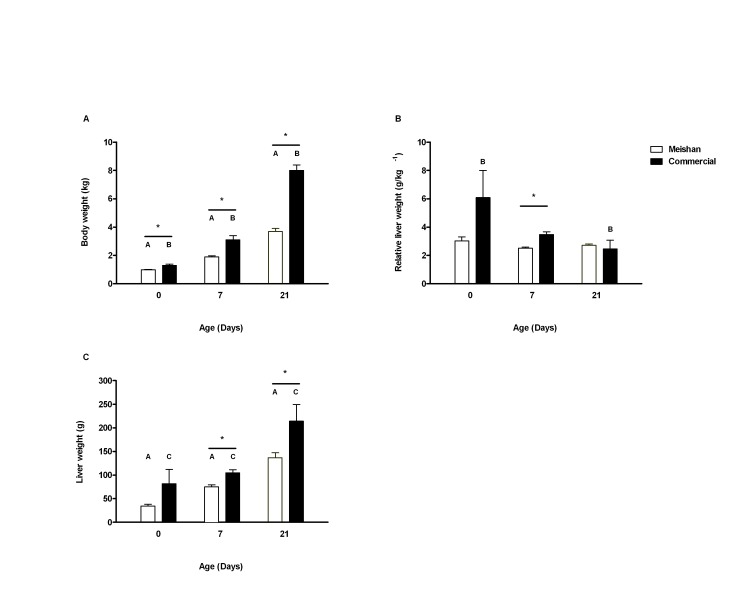
Body and liver weight with age and breed.Influence of breed on early growth in Meishan (open bars) and commercial (closed bars) piglets during the first 21 days postnatal life. (A) Changes in body weight, (B) Changes in liver weight and (C) Relative liver weight. A; p<0.05: statistical difference between the Meishan breed age groups, B; p<0.05: Statistical difference between the commercial age groups, C; p<0.05: Statistical difference between the 0 and 7 day old in comparison to 21 days old commercial breed group and *; p<0.05: Statistical difference between the same postnatal age groups. Bar graphs illustrate means ± SEM.